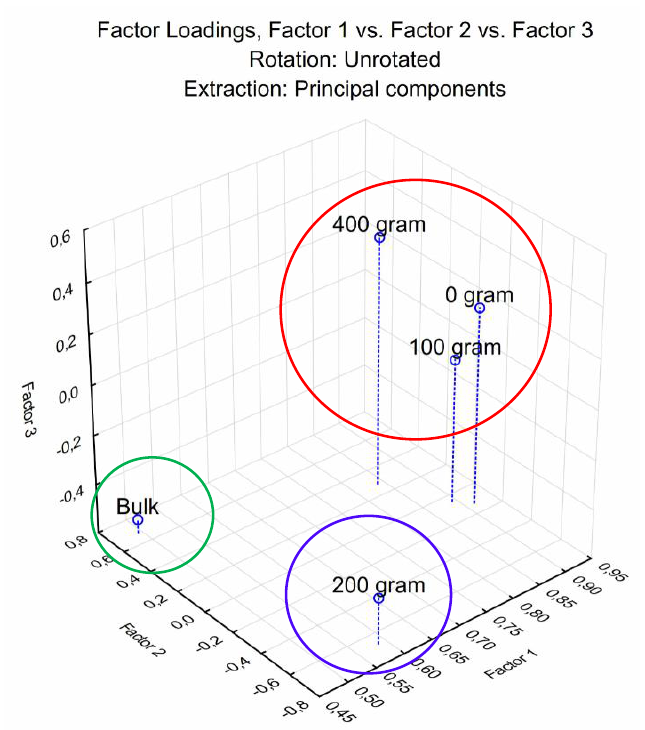
Figure 3. Principal Component Analysis (PCA) ordination plot illustrating the differences in the average carbon source utilization profiles. Treatments 0 = Control (no rhizobium), 1 = 100, 2 = 200 and 4 = 400 grams of rhizobium per 100 kg of seeds.